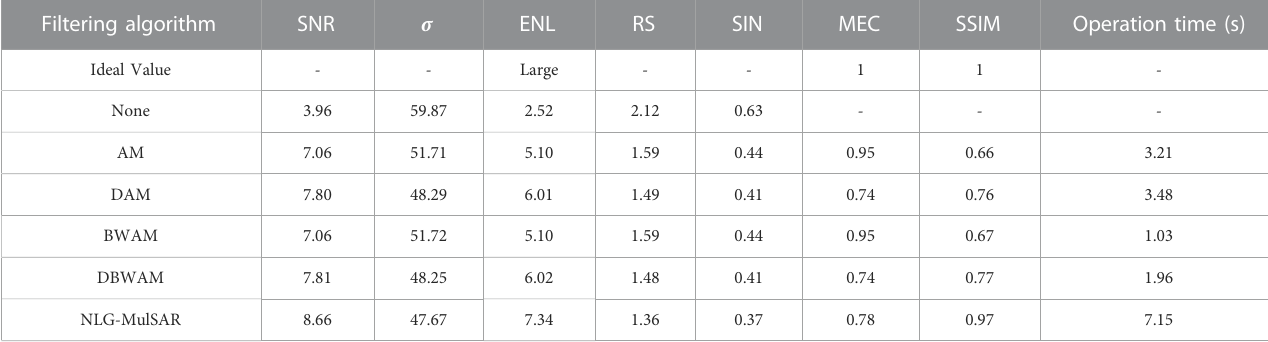
TABLE 3 Objective evaluation data table of different fi ltering algorithms. Filtering